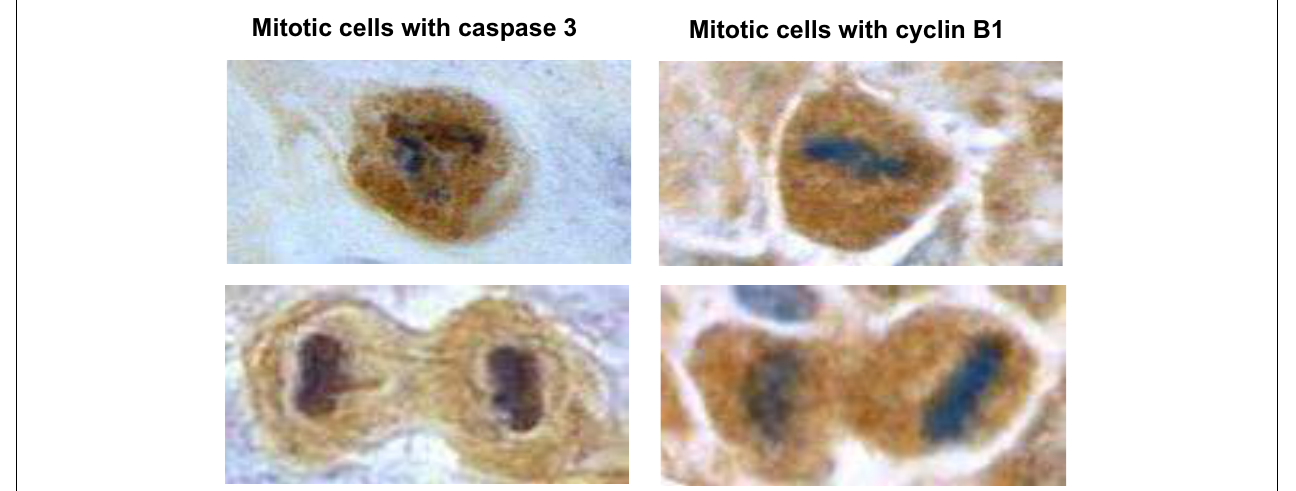
magnification = 1000-fold).The tumor sample was from a UVB-pretreated high-risk mouse treated with caffeine for 18weeks. Similar images were obtained in tumors from control mice.Taken from Lu et al.